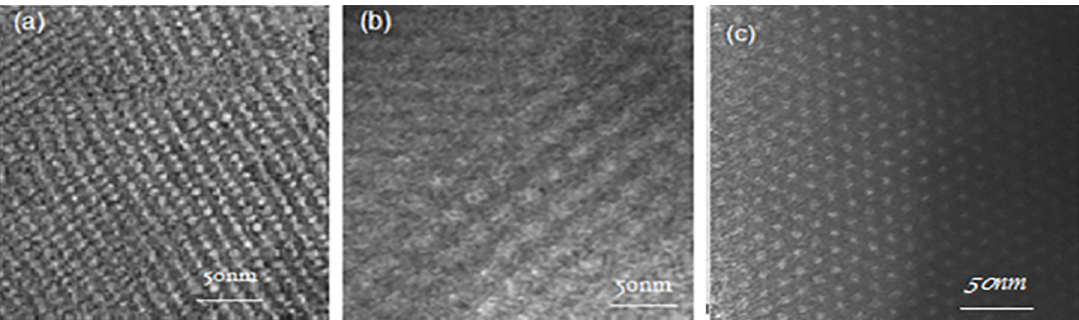
Figure 1. Low-angle XRD patterns of calcined samples: MS58, MS78 and Al-MCM41.